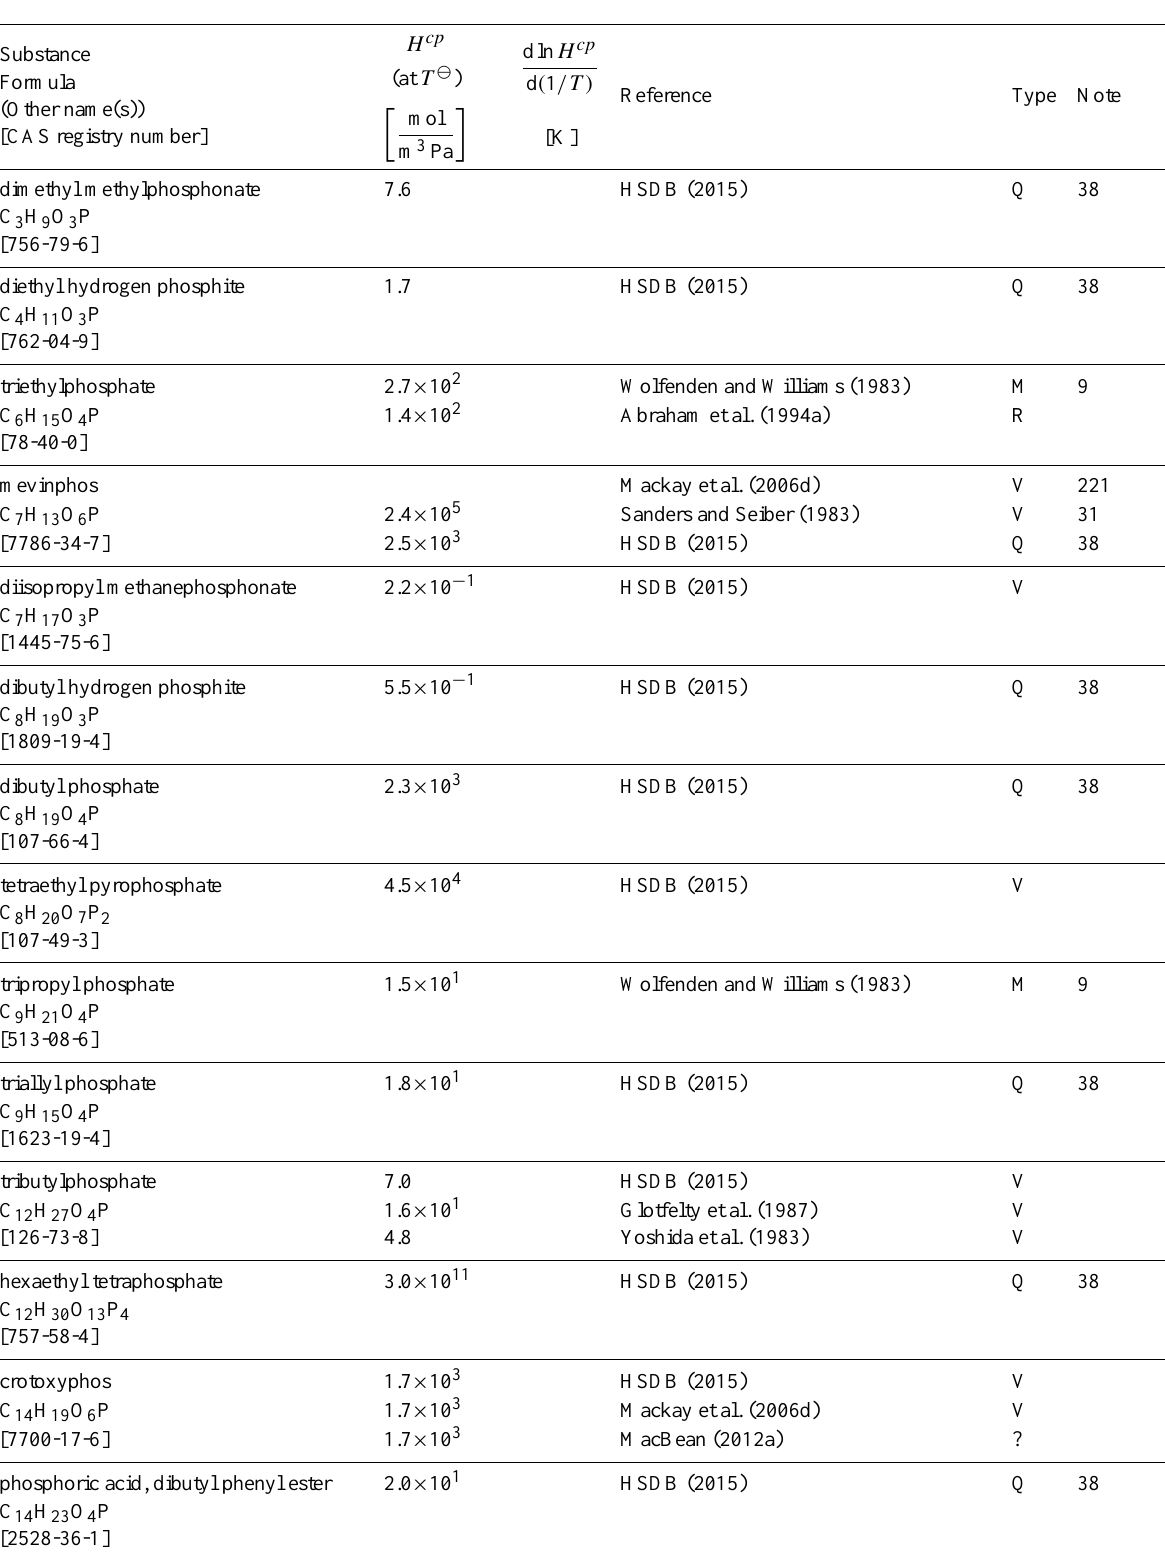
Table 6: Henry’s law constants for water as solvent